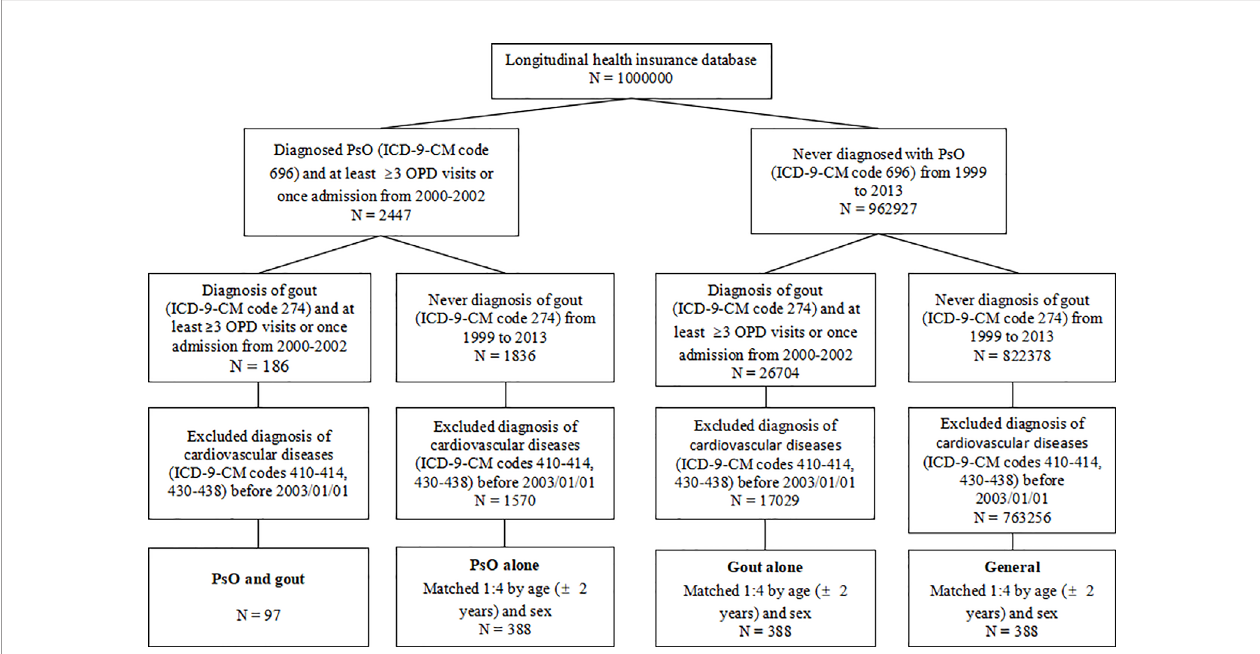
FIGURE 1 | Flow chart of the study design. PsO, psoriasis; OPD, outpatient department; ICD-9-CM, International Classi fi cation of Diseases, Ninth Revision, Clinical Modi fi